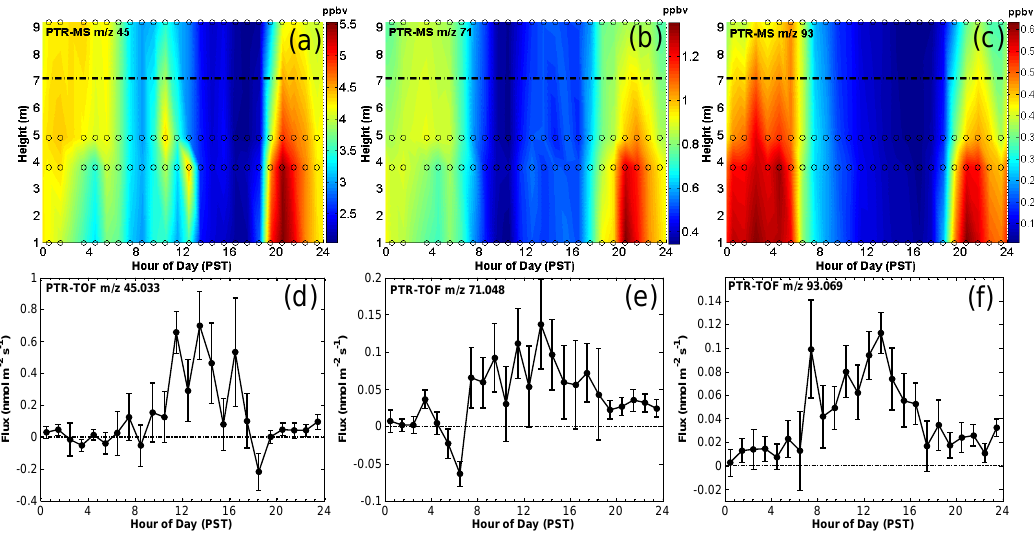
Fig. 9. Mean vertical gradient (a, b, and c, PTR-MS) and mean flux (d, e, and f, PTR-TOF-MS) diurnal patterns of acetaldehyde, MVK+MACR and para-cymene+toluene respectively. Symbols, color coding and error bars as in Fig. 8. 884 885 from orange trees (Ciccioli et al., 1999). Our